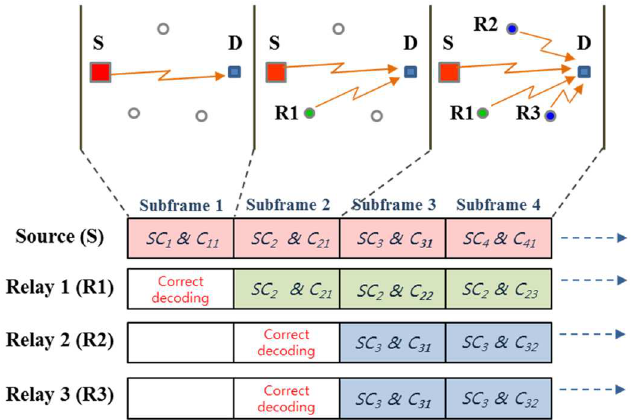
Fig 4. Fixed random selection strategy(MoDDF FS